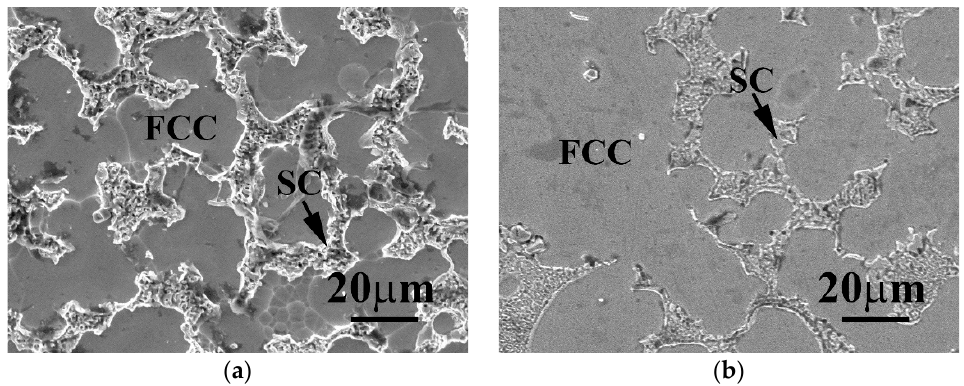
Figure 4. The micrographs of Cr 19 Fe 22 Co 21 Ni 25 Mo 13 alloy after polarization tested in the deaerated solutions of: ( a ) 1M HNO 3 solution and ( b ) 1M HCl solution at 30 °C. The corrosion time of each specimen was 1500 s.